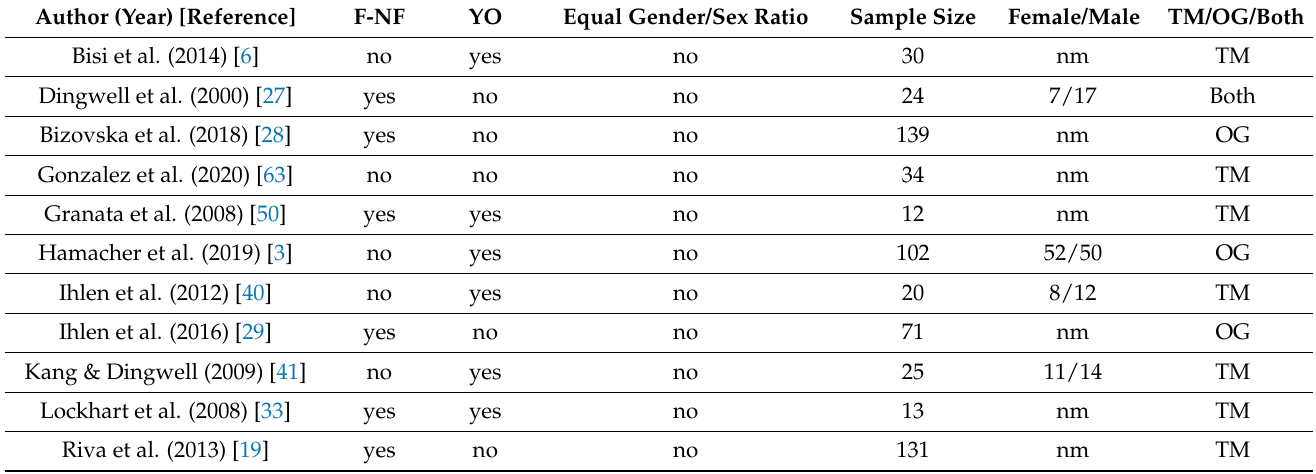
Table 1. Equal gender/ Sex ratio, sample size, participant’s gender (Female, Male or not mentioned (nm)), overground (OG) or on the Treadmill (TM) or Both (Both) cohorts in studies in corporation F-NF or YO